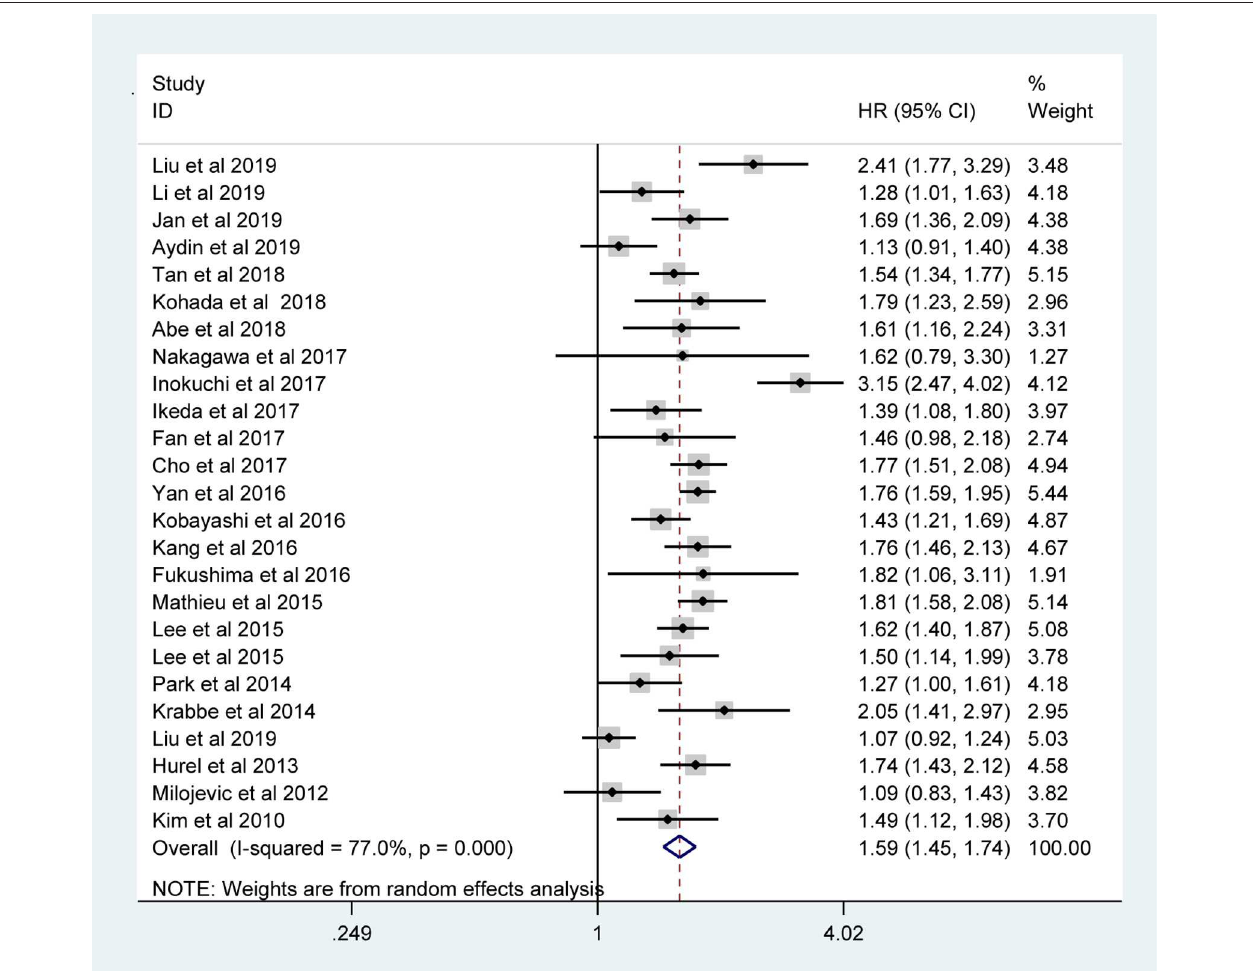
FIGURE 2 | Meta-analysis of the effect of LVI on